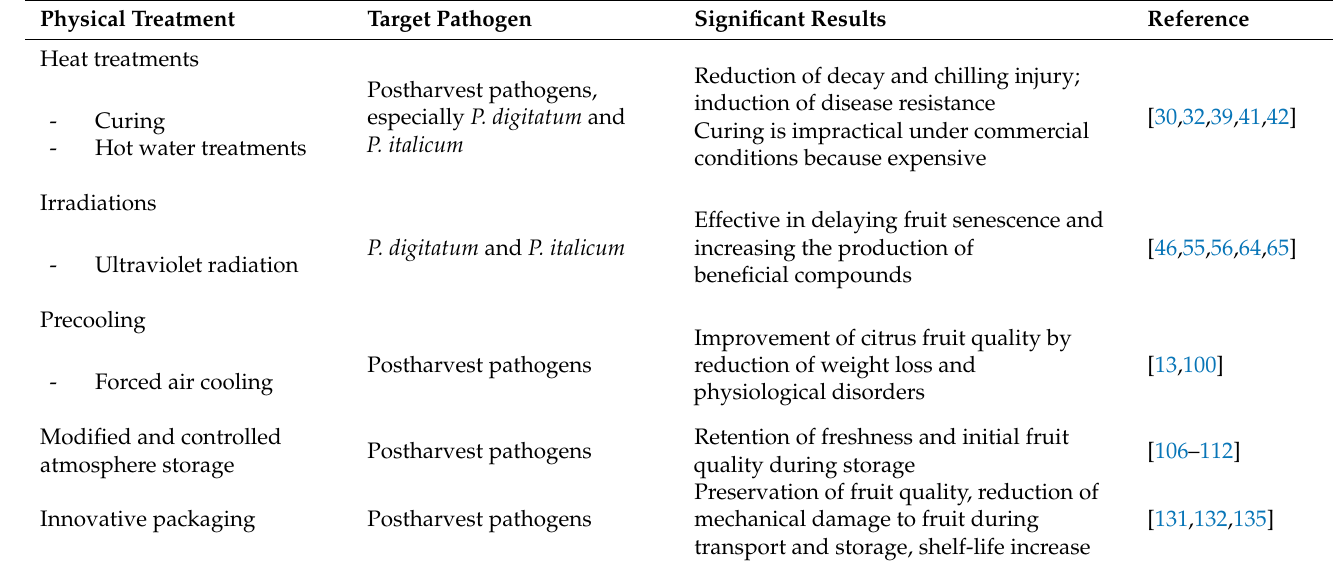
Table 3. Summary of studies on physical treatments effective for postharvest rot control of citrus fruit. Physical